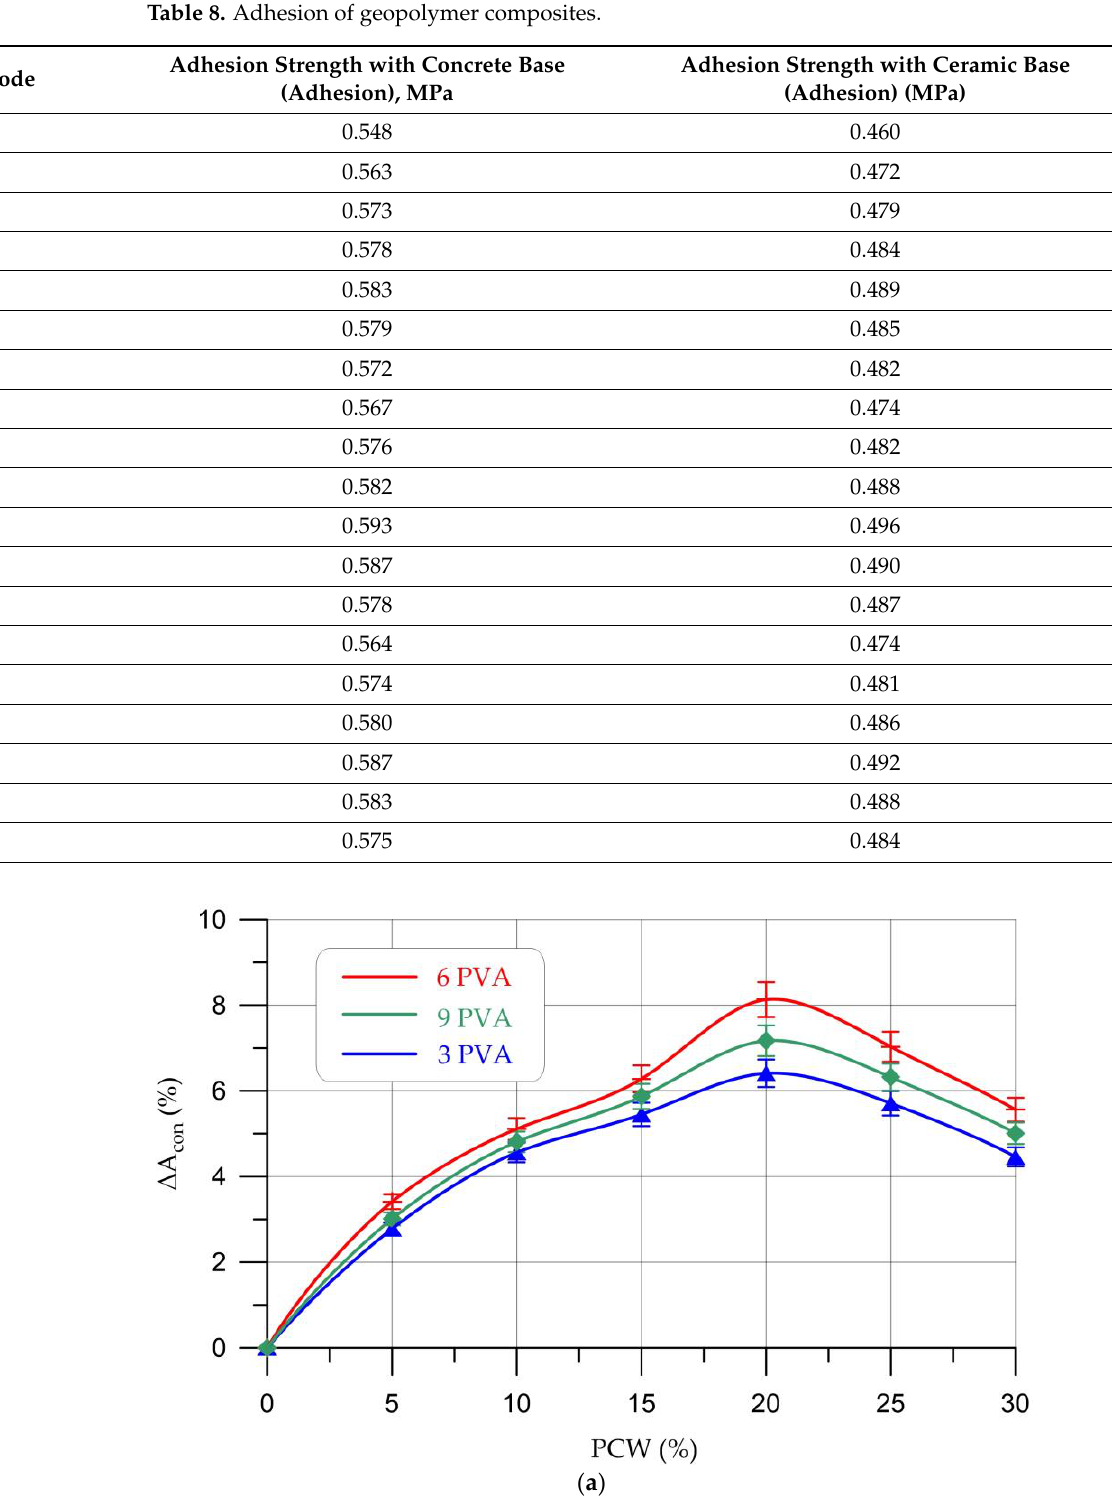
Table 8. Adhesion of geopolymer composites.